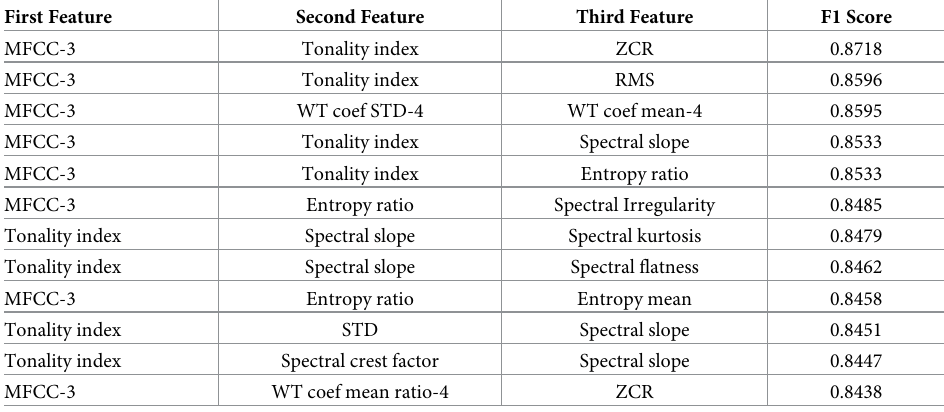
Table 11. F1 score of the best three features vectors for wheeze and normal sound classification using logistic regression on the